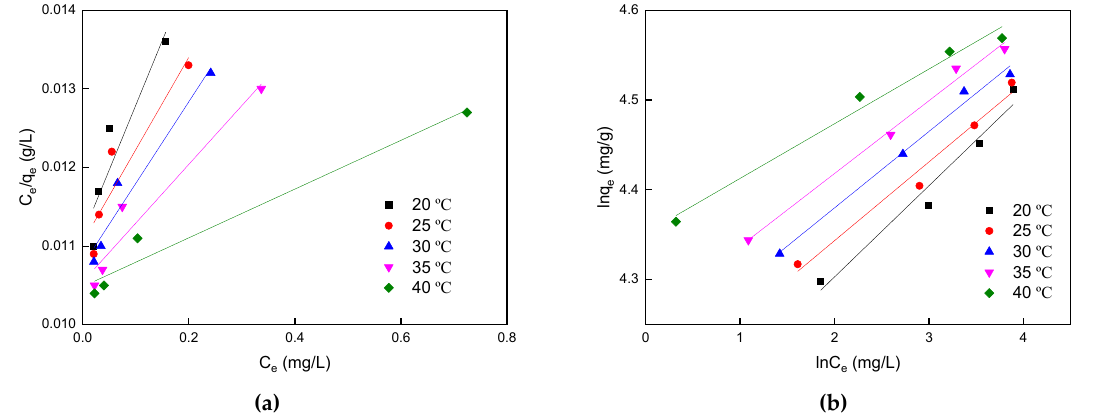
Figure 8. Adsorption isotherms at different temperatures. ( a ) Langmuir isotherm model; ( b ) Freundlich isotherm model. Table 3. Parameters of isotherm models.